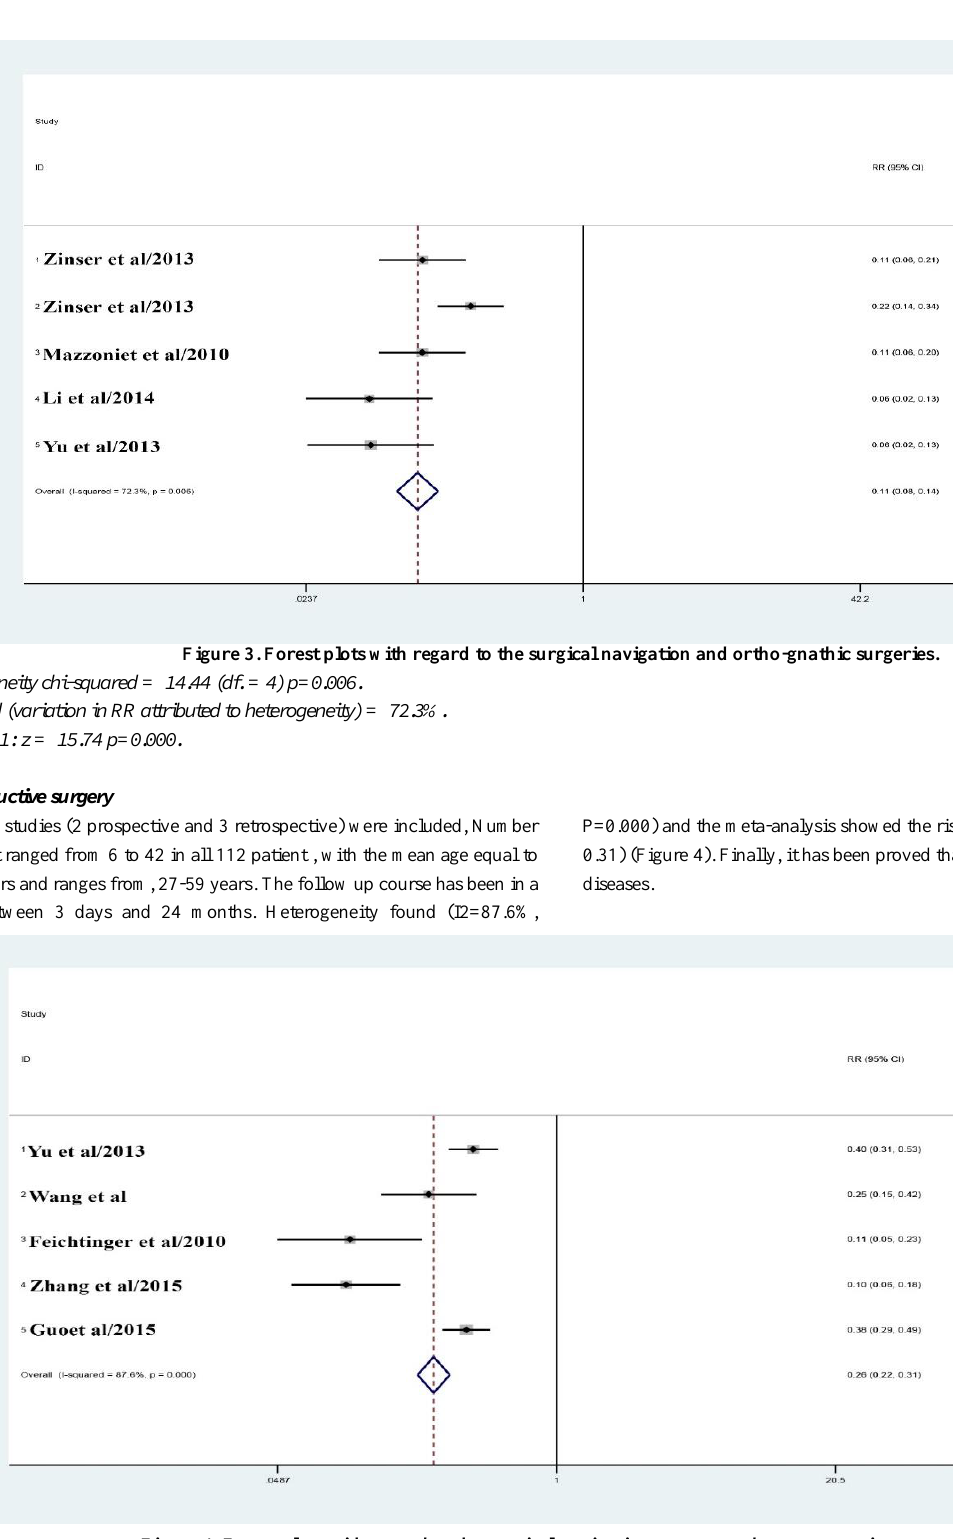
Figure 4. Forest plots with regard to the surgical navigation, cancer, and re-constructive surgeries. Heterogeneity chi-squared = 32.21 (df. = 4) p=0.000. I-squared (variation in the RR attributed to heterogeneity) = 87.6%. RR test = 1: z = 14.99 p =